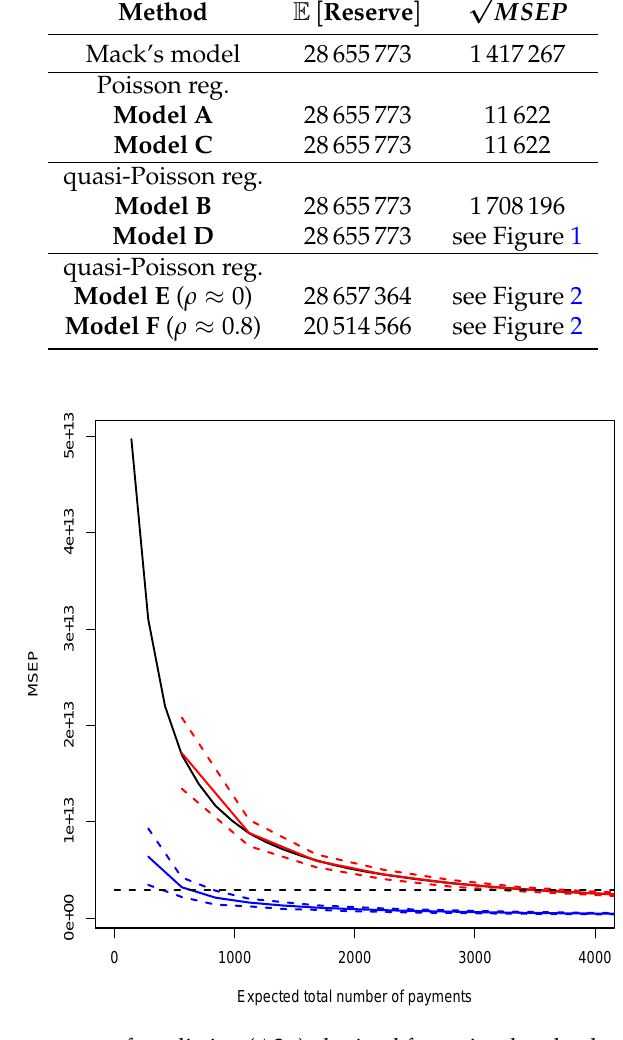
Figure 2. Mean square error of prediction ( ± 2 σ ) obtained from simulated values as a function of the expected number of payments for Model E ( red lines) and Model F ( blue lines). For comparison purposes, the MSEP obtained for the Model D ( solid black line) and the Model B ( broken black line) are